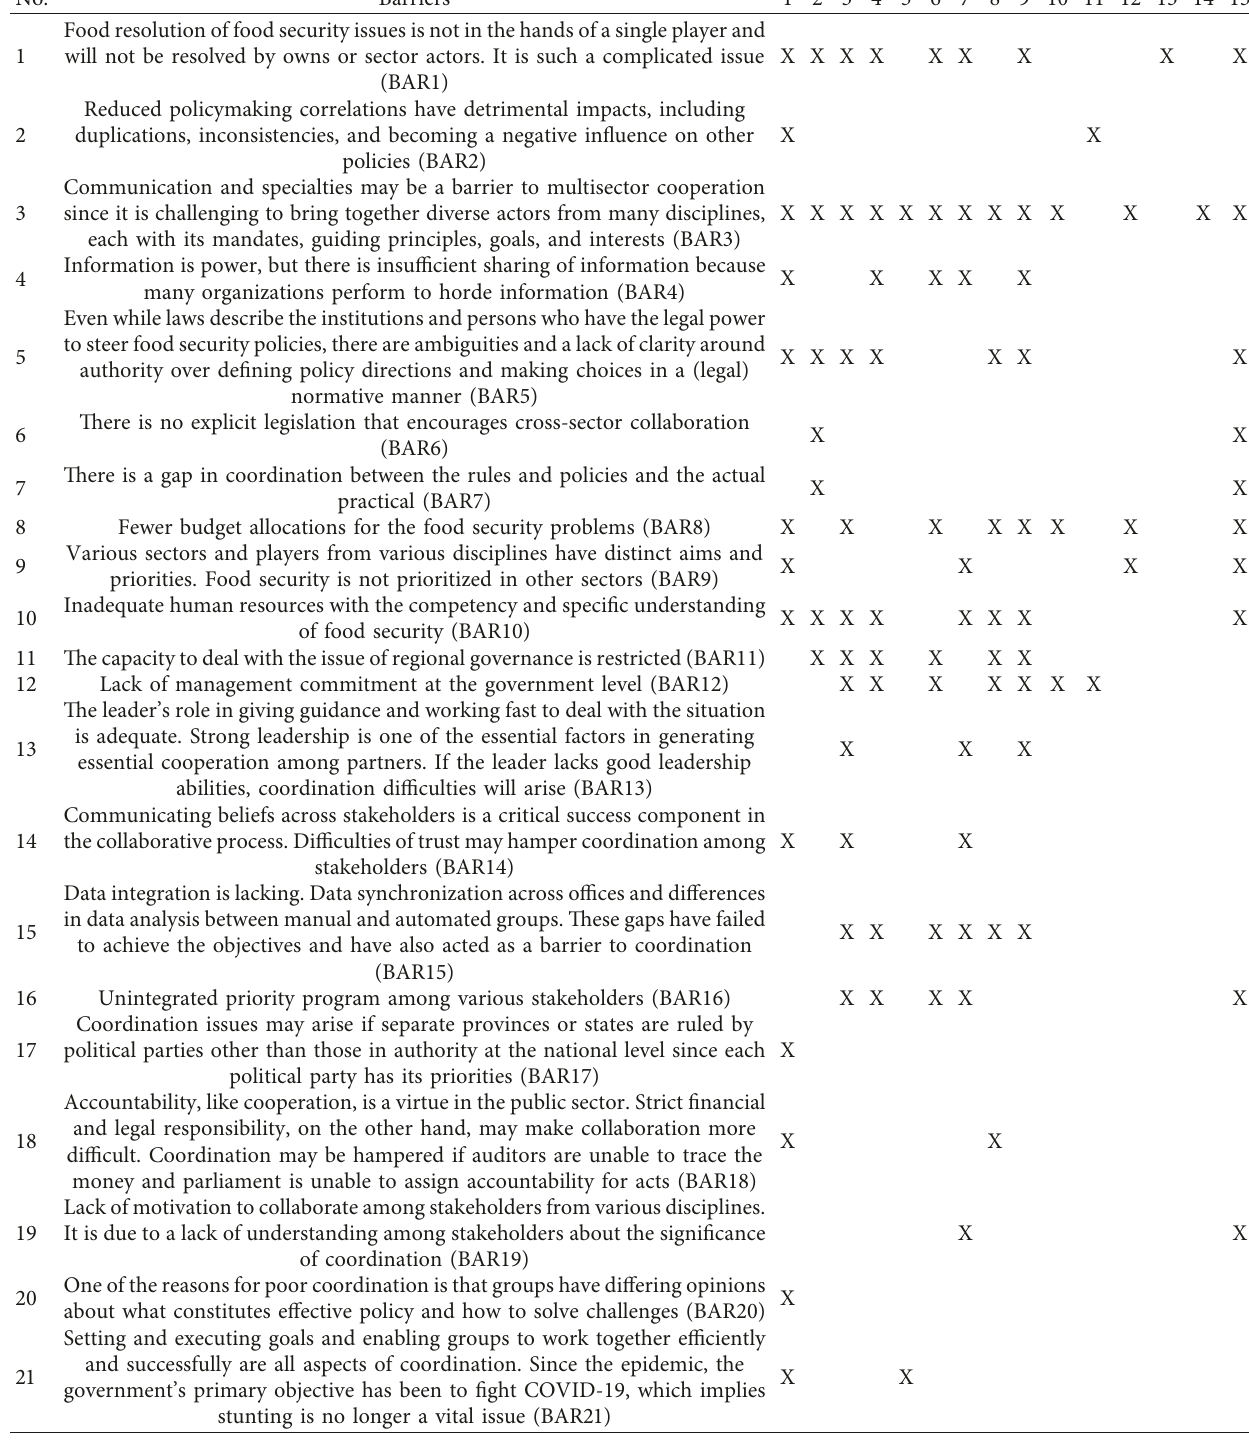
Table 1: Factors or barriers for public policy